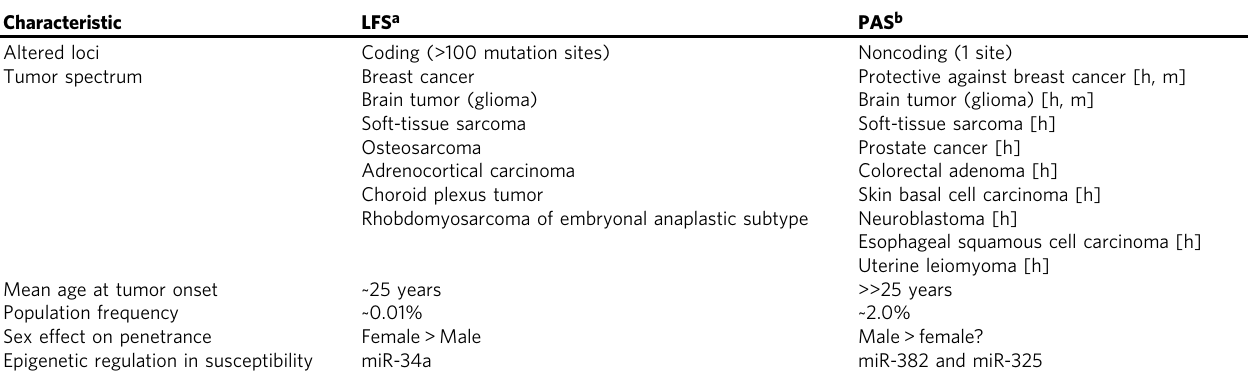
Table 2 TP53 germline coding mutations and the noncoding variant in cancer patients